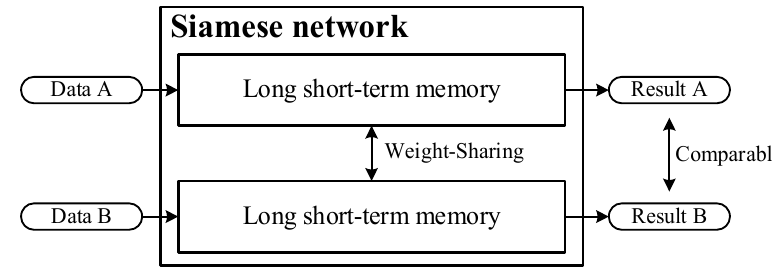
Figure 11. Siamese network used to evaluate the results. After factors are calculated via the Siamese network formed by the long short-term memory model, the fully connected layer evaluates food safety factors, allergen factors, food defense factors, and food fraud factors. Figure 12 illustrates the fully connected layer used to evaluate the scenario of food safety. Figure 13 illustrates each node of the fully connected layer in detail. upper-layer nodes by the weight of their edge, then combine all of the products and bias to obtain the value of the node [44]. Finally, the result of the tanh function, with a value between 1 and − 1, is output, as shown in Equation